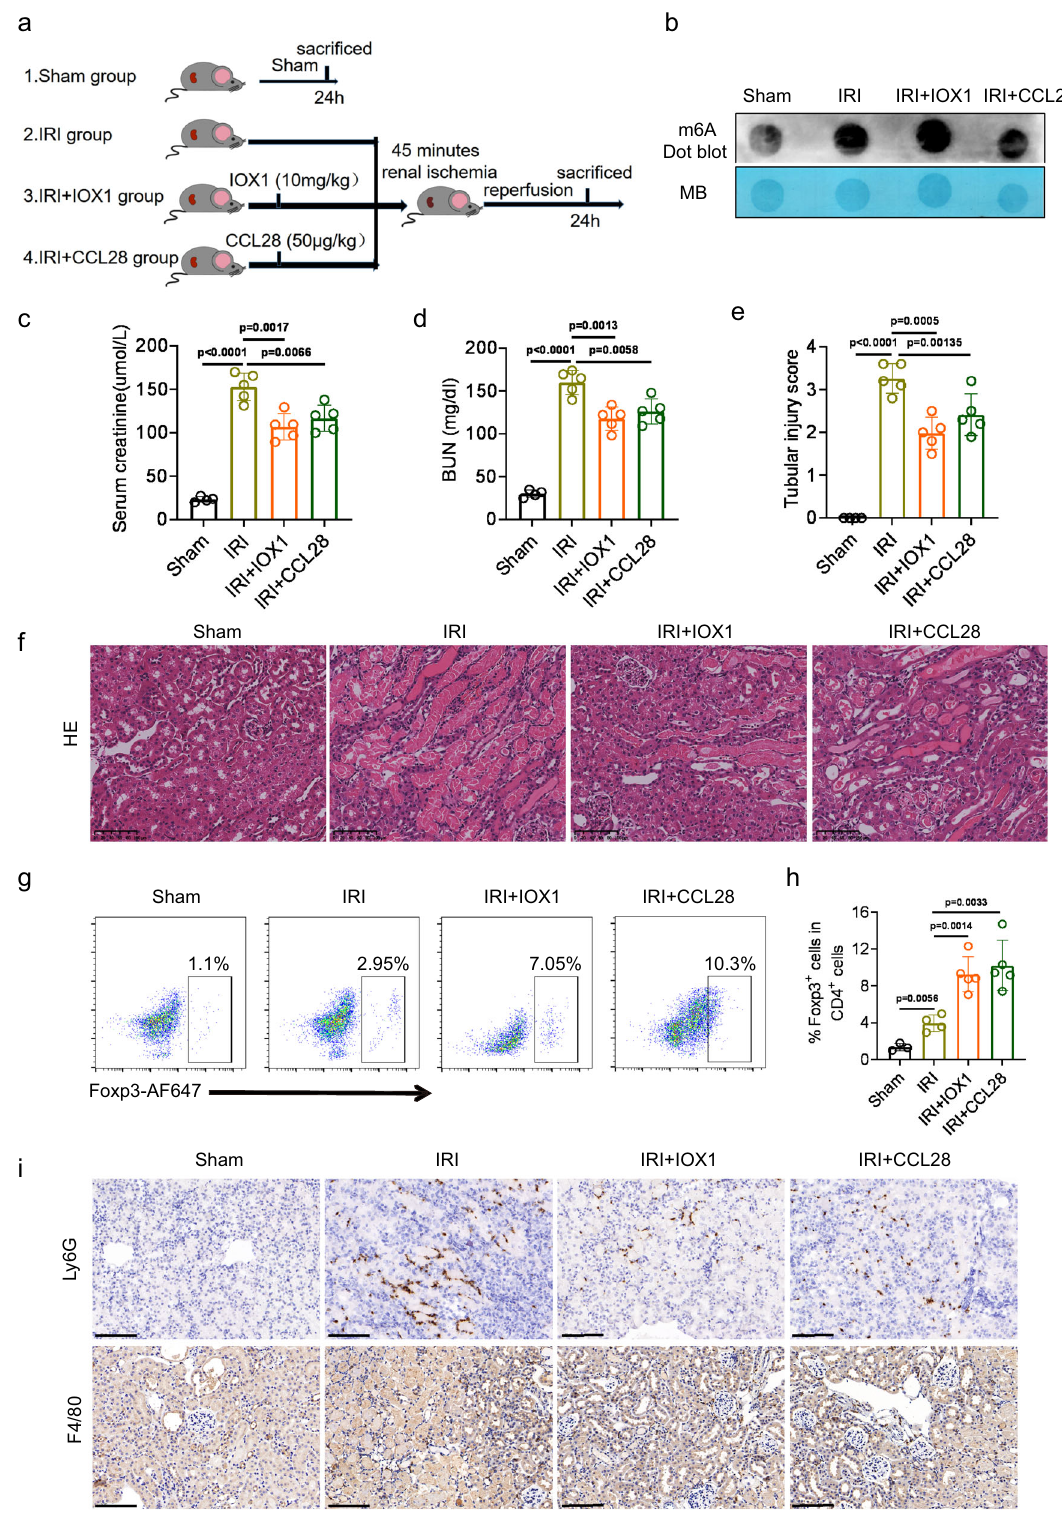
Fig. 8 | IOX1 and recombinant mouse CCL28 exerts protective effects in vivo during IRI. a Schematic illustrating experiment groupsand treatment in 4 groups. b m6Adotblotassessedm6AmRNAmethylationunderIOX1orCCL28treatmentin I/R-induced AKI mouse model. c , d Serum creatinine and BUN concentrations. e , f Tubularinjuryscoreand representative H&Estaining image indifferentgroups of renal tissues. g , h Representative fl ow cytometry dot plots and percentage of CD4 + Foxp3 + cells among the CD4 + T cells in IRI mice with or without IOX1 and